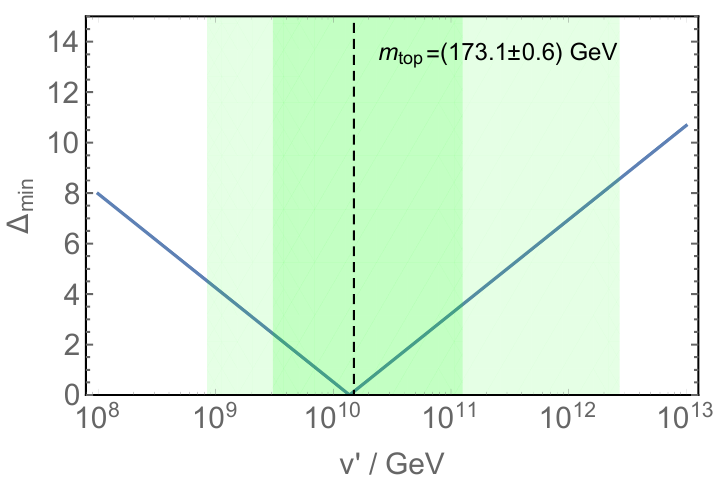
Figure 1 . The quality of gauge coupling uni(cid:12)cation as a function of v 0 . The vertical dark (light) band shows the prediction for v 0 from the vanishing Higgs quartic coupling at 1 (cid:27) (2 (cid:27)